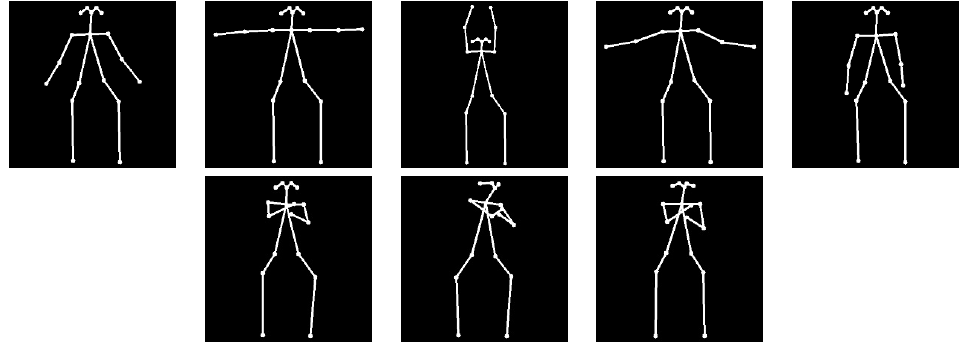
Figure 6. Human skeleton sequence encoding the required human positions to successfully do the arm raises exercise ( top ) and the upper body twist exercise ( bottom